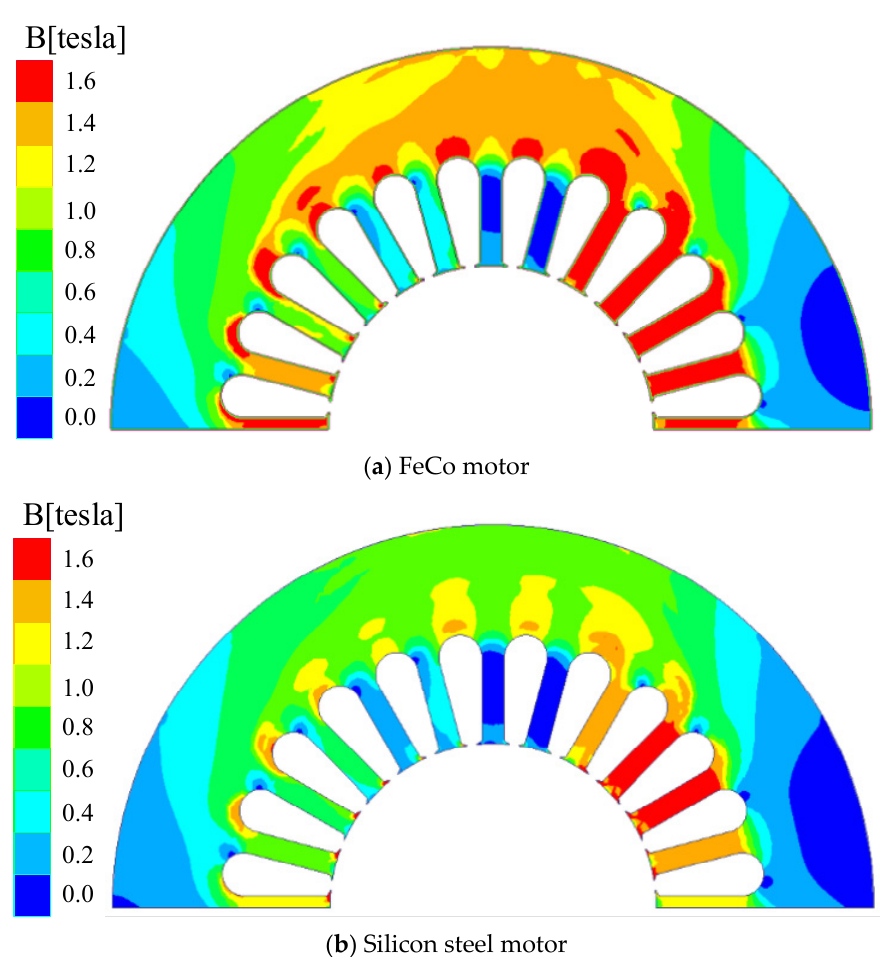
Figure 16. Comparison of magnetic density at 1.2 times the load.